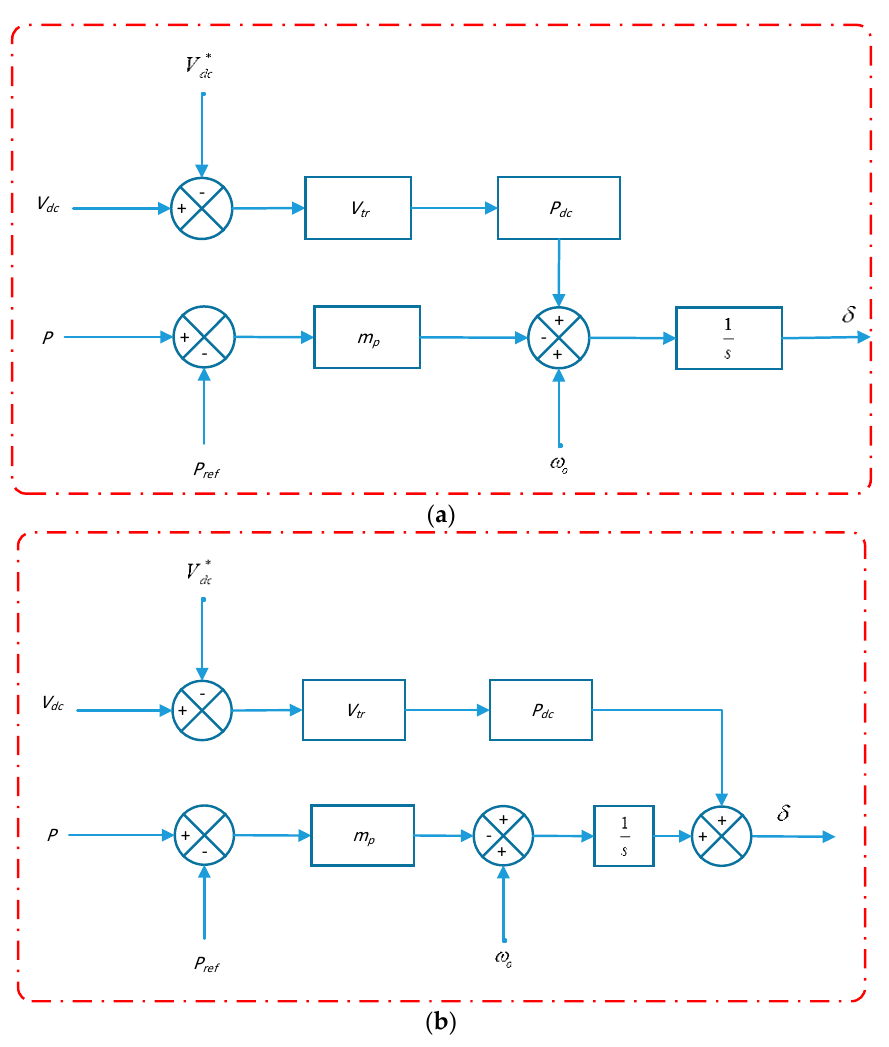
Figure 17. Diagrams of proposed controller where ( a ) is frequency loop, and ( b ) is the phase loop.